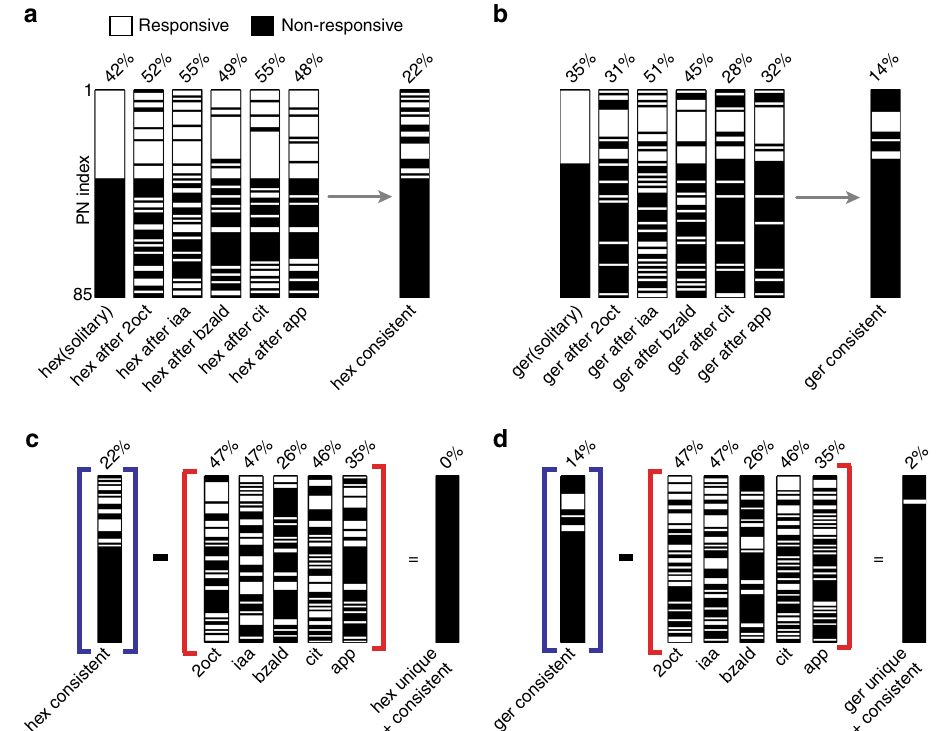
Fig. 3 Evaluating the stability of the combinatorial code. a Each projection neuron was classi fi ed as being ‘ responsive ’ or ‘ non-responsive ’ to the target stimulus (Methods) and the classi fi cation of all 85 neurons are shown as a barcode. This binary classi fi cation was done for solitary and sequential introductions of hexanol. Note that all barcoded PNs are identically sorted and displayed to facilitate comparison. The percentage of PNs classi fi ed as being responsive during each hexanol presentation is shown above the barcode. The set of PNs classi fi ed as being responsive for all hexanol introductions is identi fi ed as the ‘ consistent set ’ and is also shown as rightmost barcode. b Similar plot as in a but comparing geraniol responsive and non-responsive set of PNs is shown. c Barcodes identifying responsive and non-responsive PNs for the fi ve different distractor stimuli are shown. These PNs were removed from the set of neurons activated during all introductions of hexanol i.e., ‘ the consistent set ’ , to identify those PNs that were both consistent and unique responders to hexanol (the rightmost barcode). As can be noted, this is an empty set for hexanol. d Similar plot as in c but identifying the unique and consistent set of PNs that responded to geraniol. For geraniol, this set consisted of only 2% of the